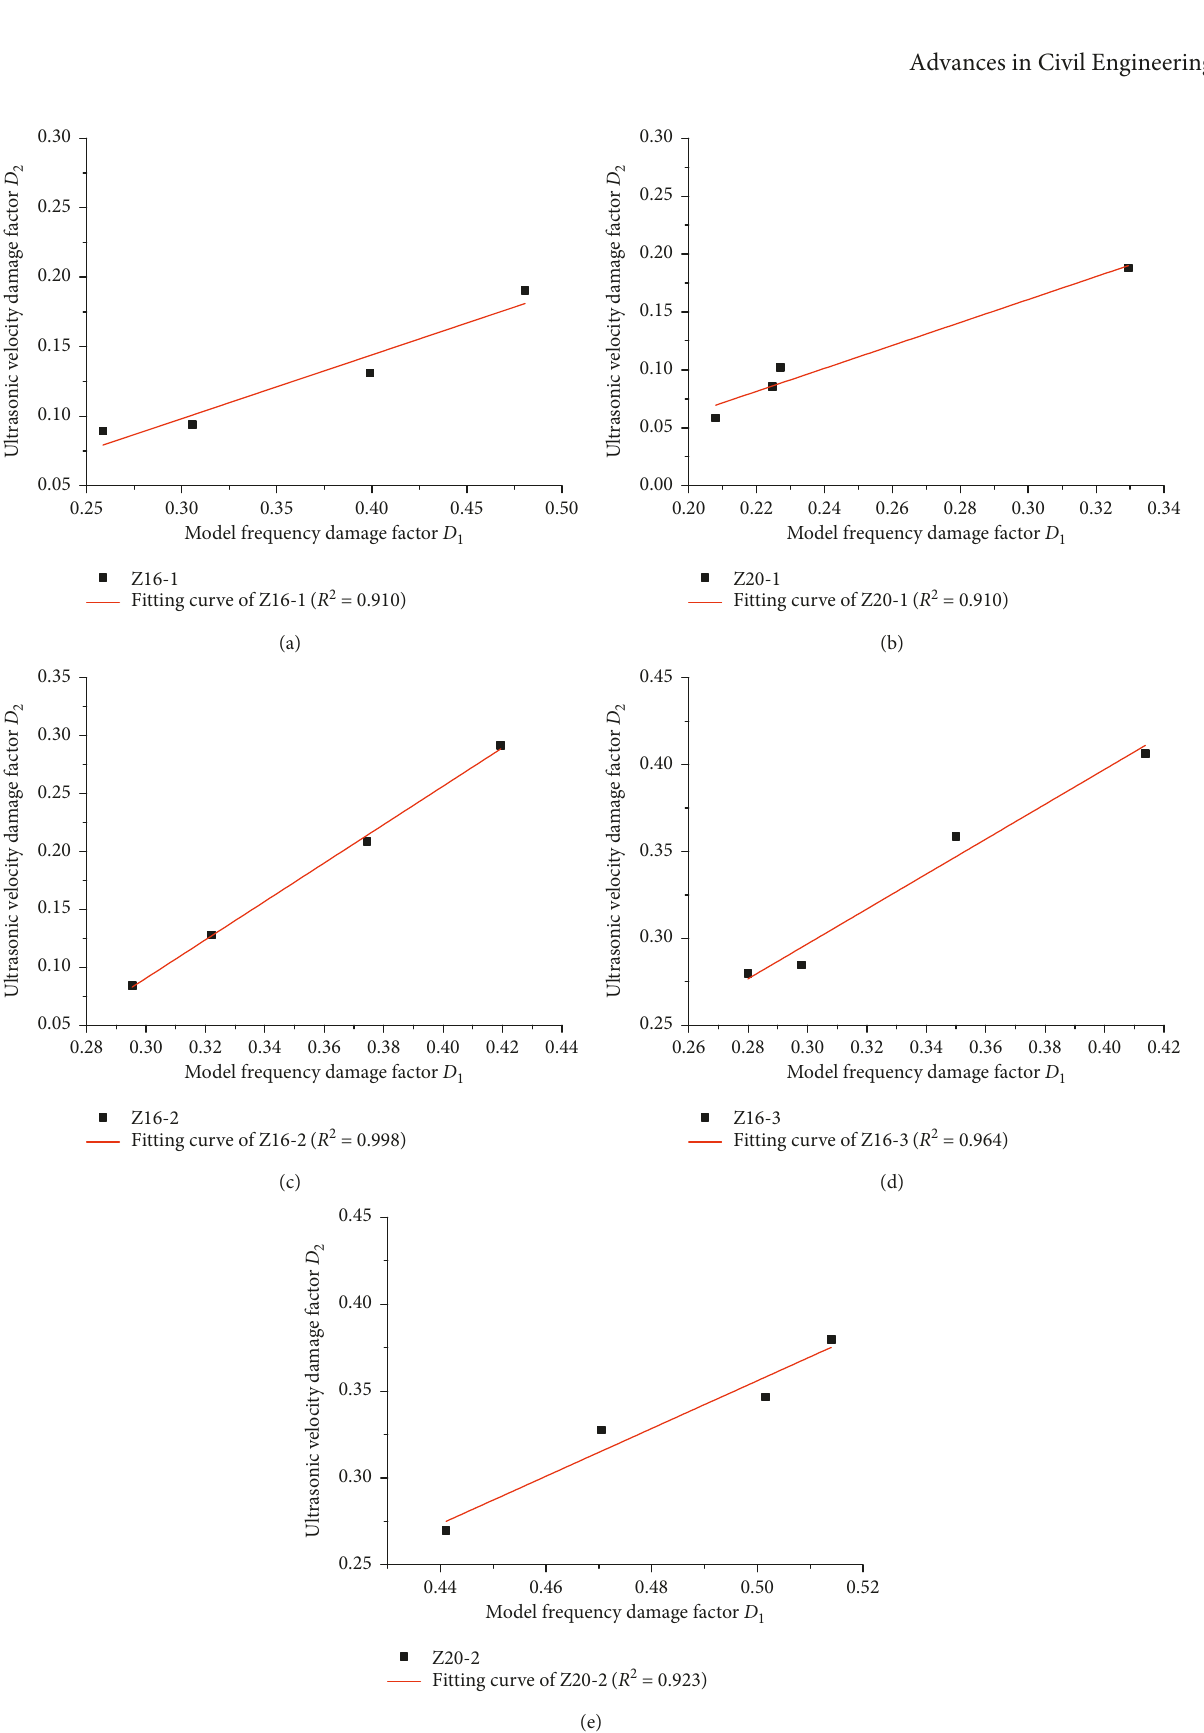
Figure 17: Fitting curves of the modal frequency damage factors and the ultrasonic velocity damage factors. (a) Fitting curve of Z16-1, (b) fitting curve of Z20-1, (c) fitting curve of Z16-2, (d) fitting curve of Z16-3, and (e) fitting curve of